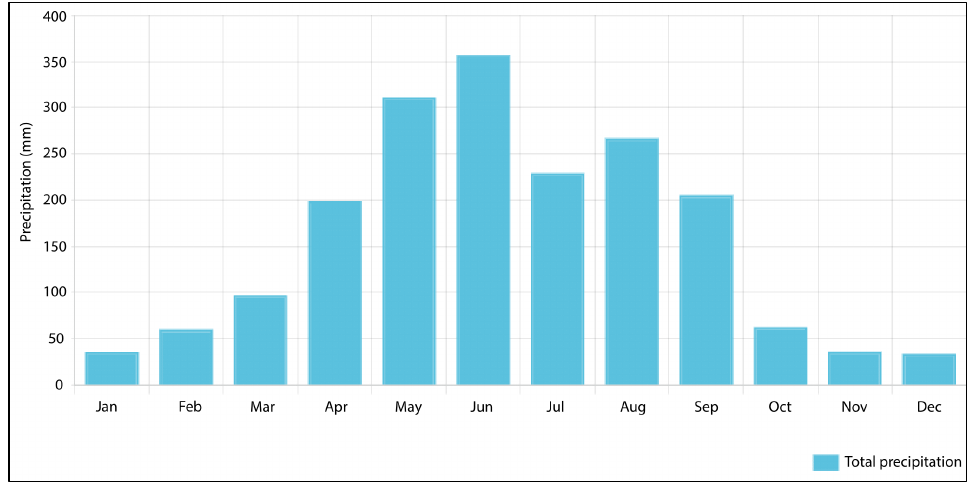
Figure 3. Monthly precipitation, 1991 – 2020.